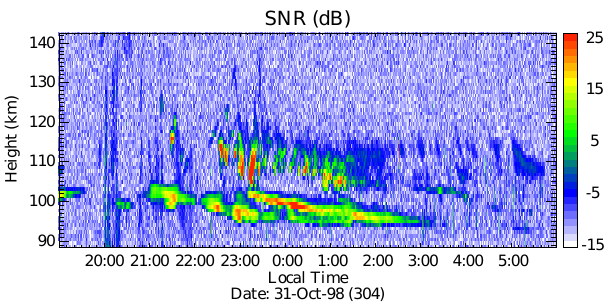
Fig. 1. Example of altitude-time signal-to-noise ratios from E- region